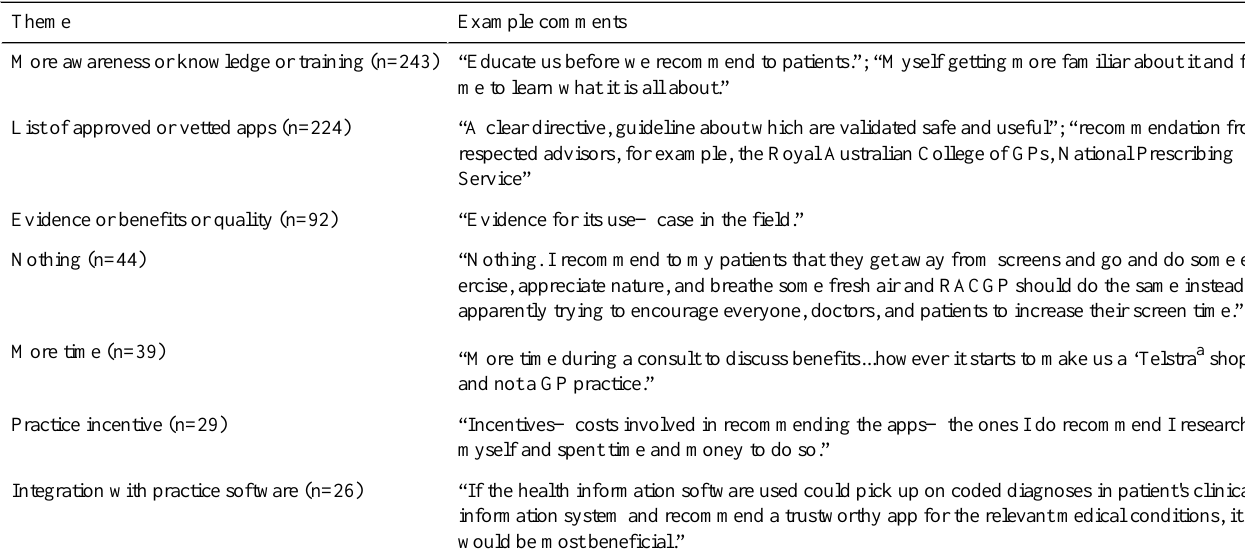
Table 2. Facilitators of app prescription as responses to question “What would help you to recommend health apps to patients more often?” A total of 683 replies were coded into 800 answers. All other themes (n=9) had less than 25 answers each to support them. Example